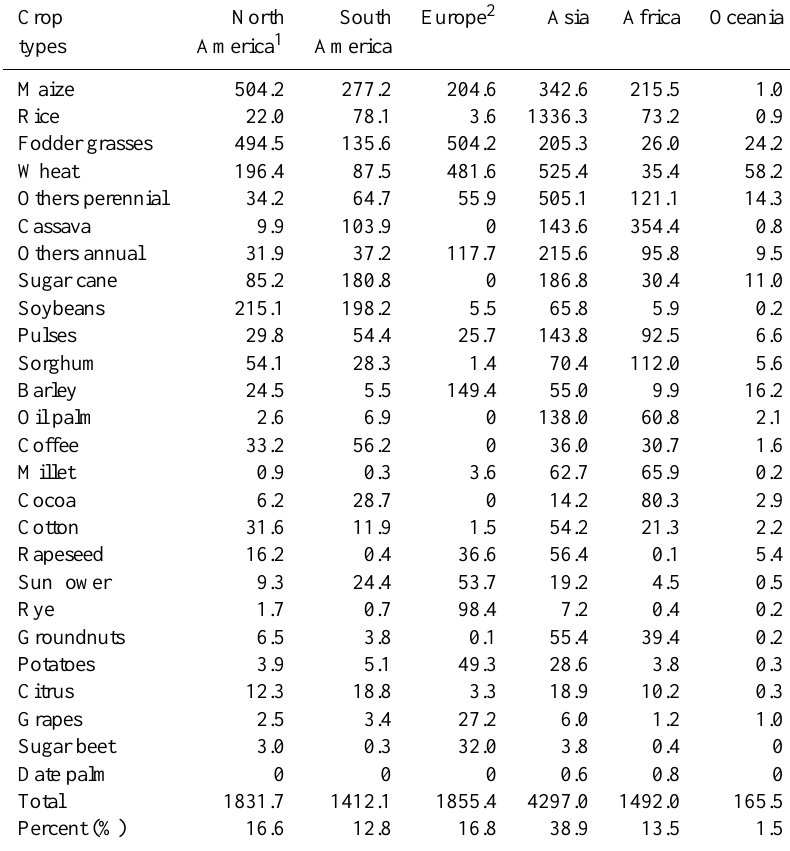
Table 3. Annual GPP (TgCyr − 1 ) for different regions in the year 2000. Crop